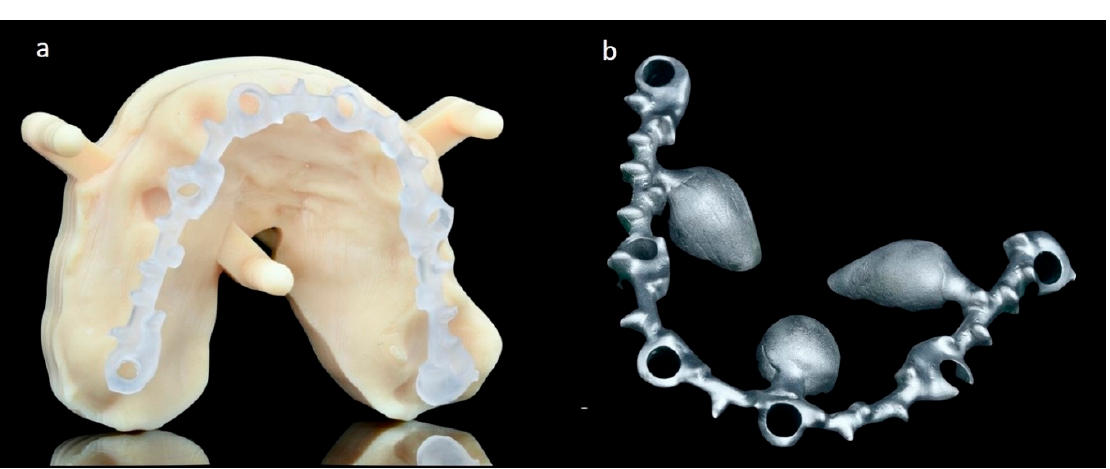
Figure 5. Pterygoid implant beds’ preparation with the printed surgical guide fixed in place: the cortical perforator ( a ), the following twist drill ( b ), the shaping drill burs ( c ), and the implant seating with the implant carrier ( d , e ).